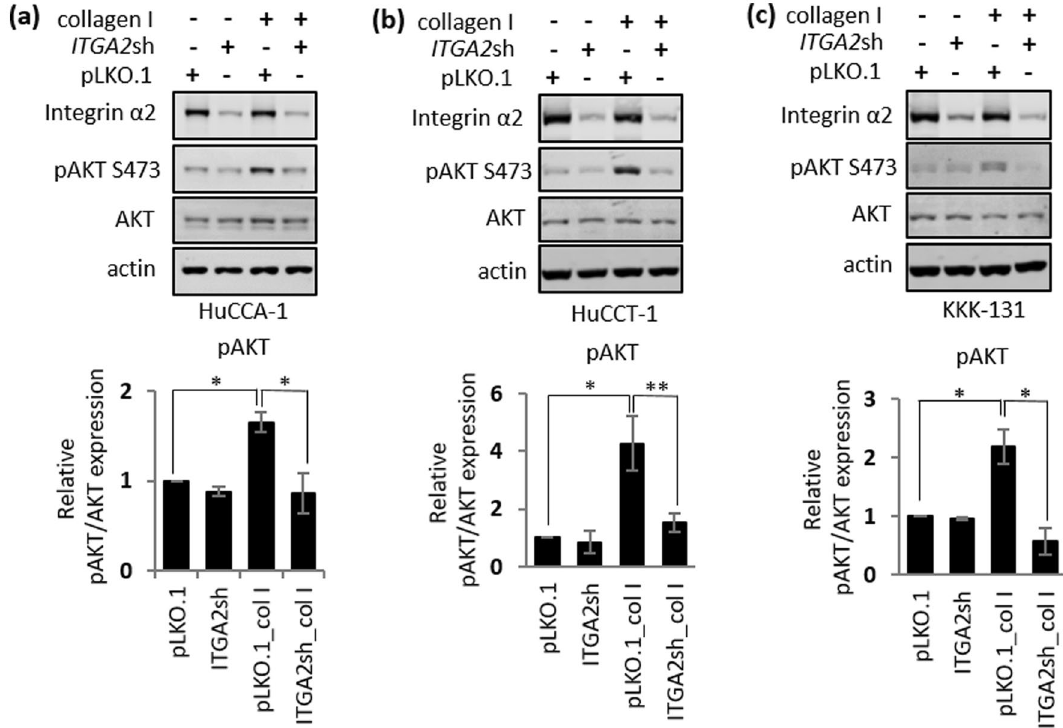
Figure 5. Integrin α2 is required for collagen type I-mediated AKT phosphorylation. Immunoblot analysis of ( a ) HuCCA-1, ( b ) HuCCT-1, and (c) KKK-131 cells stably expressing pLKO.1 vector control or pLKO.1- ITGA2 shRNA ( ITGA2 sh) after 1 h adhesion on uncoated or 10 μg/mL collagen I. Actin serves as a loading control. Quantification of band intensity was shown on the bottom. Relative phosphorylated protein expressions were normalized to the corresponding total protein. The bar graphs represent the mean ± SD from at least three independent experiments. The Student’s t-test was used to calculate p -value. * p < 0.05; ** p <